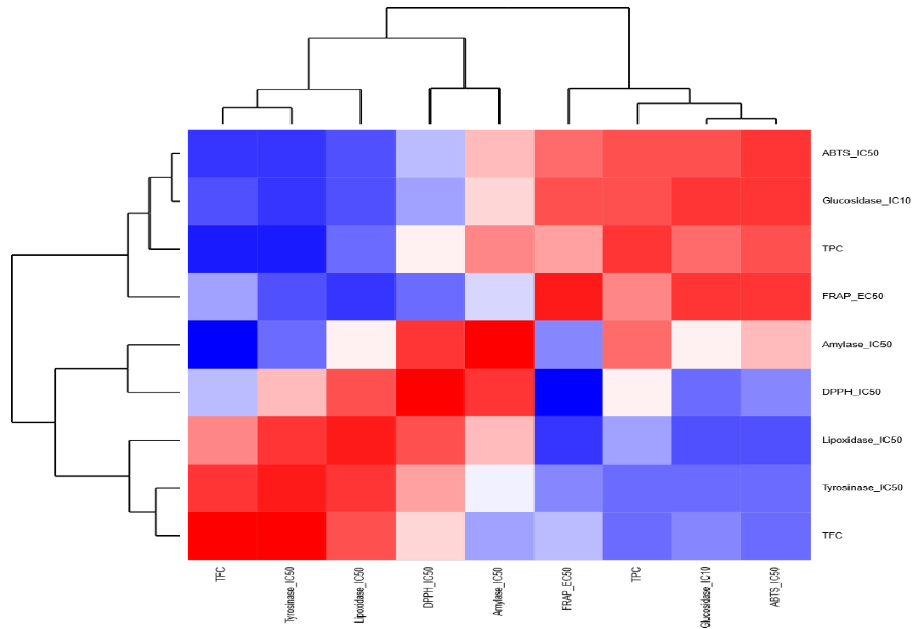
Figure 6. Heatmap highlighting the relationships among the chemical screenings within the methanolic extract of bark.